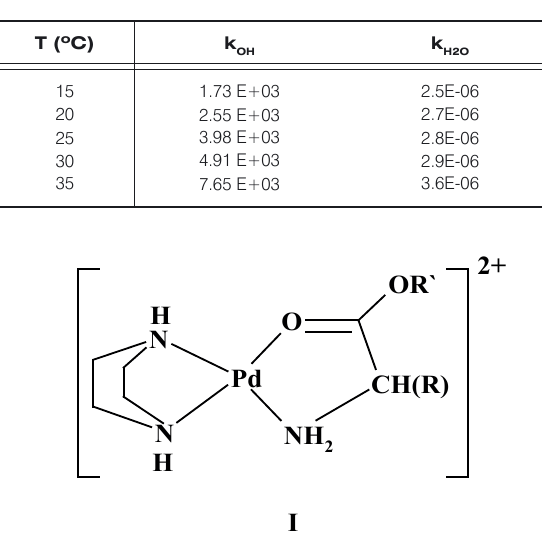
Table 4. Hydrolysis data (dm 3 mol -1 s -1 ) of [Pd(pip)(GlyOMe)] 2+ at different temperatures in aqueous